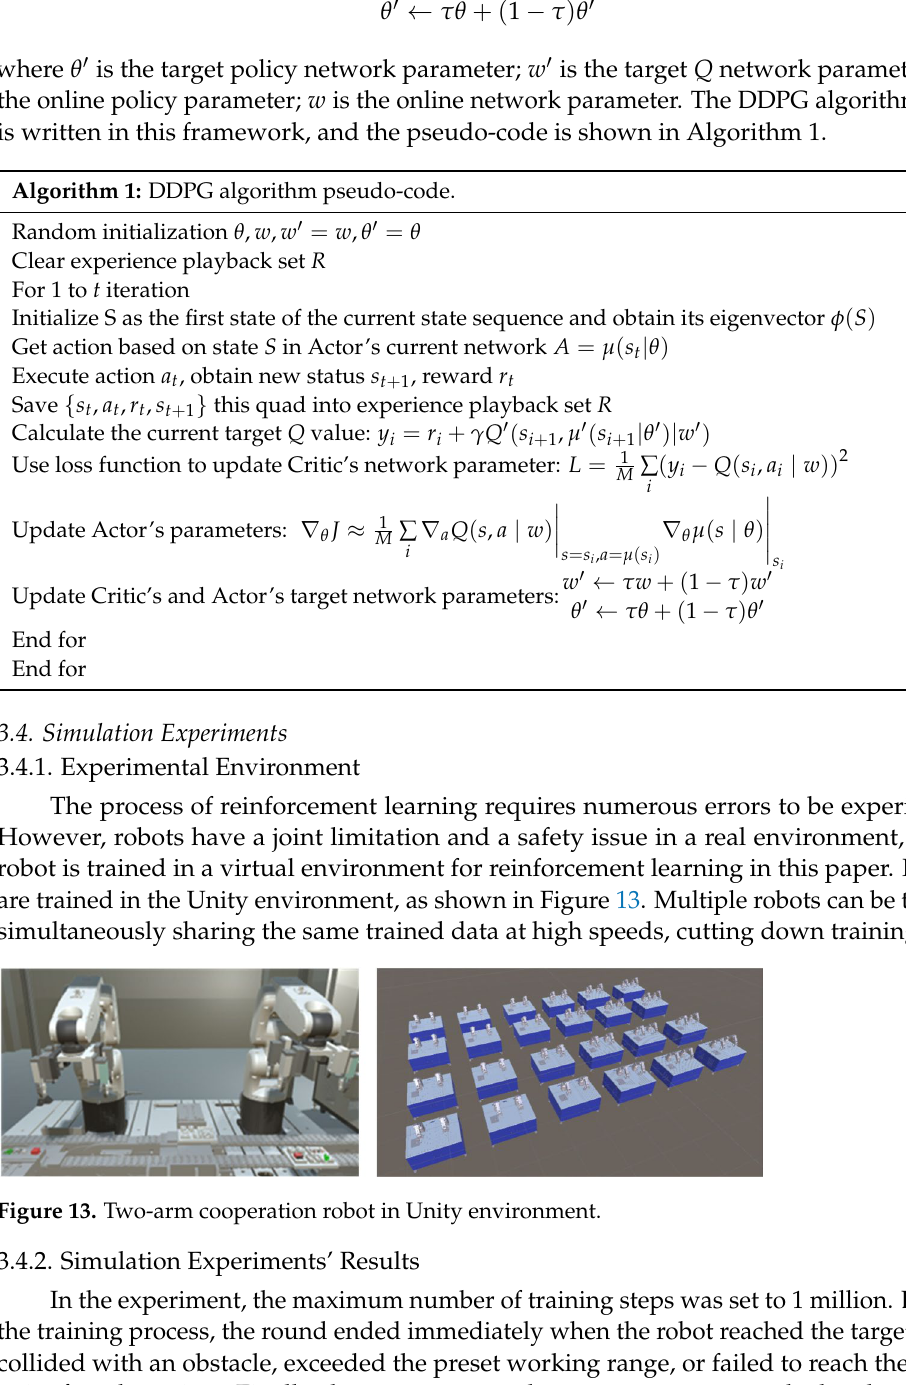
Algorithm 1: DDPG algorithm pseudo-code.